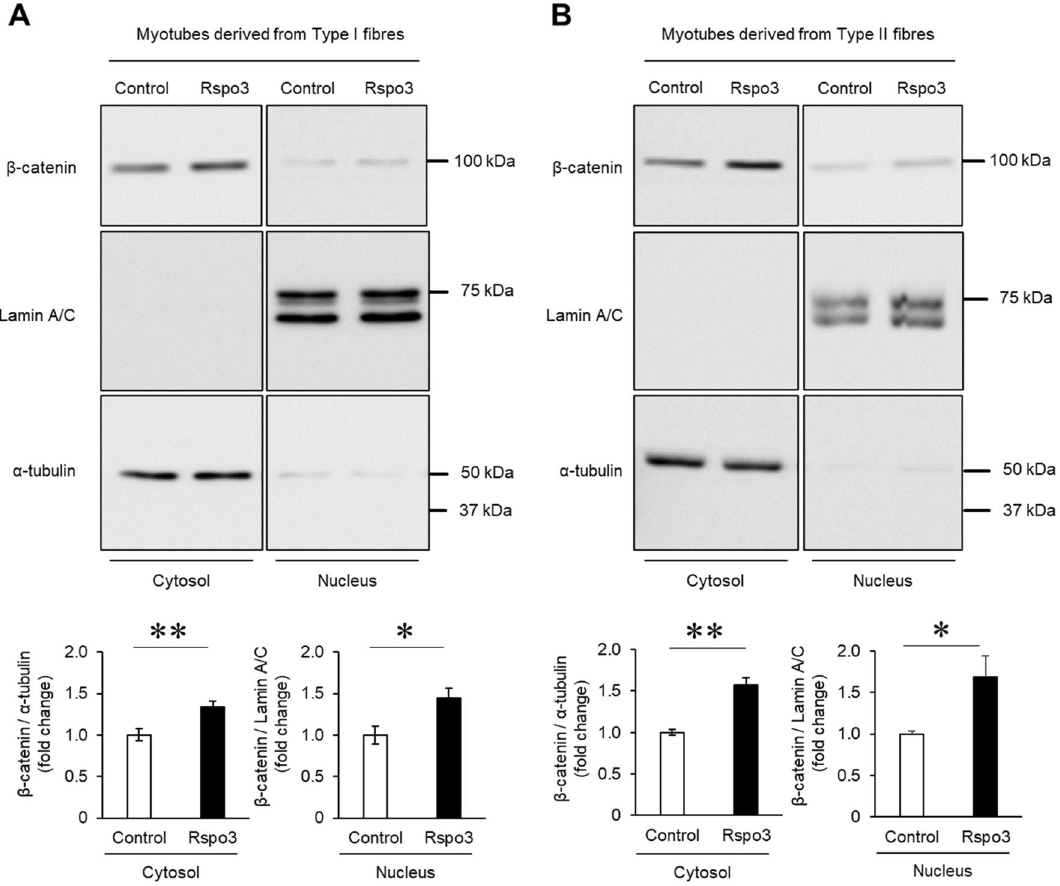
Figure 3. Rspo3 activates the Wnt/β-catenin signalling pathway during myogenic differentiation. ( A , B ) Mouse primary myoblasts derived from satellite cells of type I and type II fibres were differentiated for 3 d in the absence (BSA; 200 ng/mL) or presence of the mouse Rspo3 recombinant protein (200 ng/mL; 6.45 nM). Cytoplasmic and nucleic fractions were extracted from myotube lysate. Protein levels of β-catenin, lamin A/C (nuclear marker), and α-tubulin (cytosol marker) in myotubes were analysed using Western blotting. Values are presented as mean ± SEM (n = 10–12 mice for analysing cells derived from type I fibres, n = 8 mice for analysing cells derived from type II fibres). * P < 0.05; ** P < 0.01 by Student’s t-test. Uncropped blots can be found in Supplementary Fig.